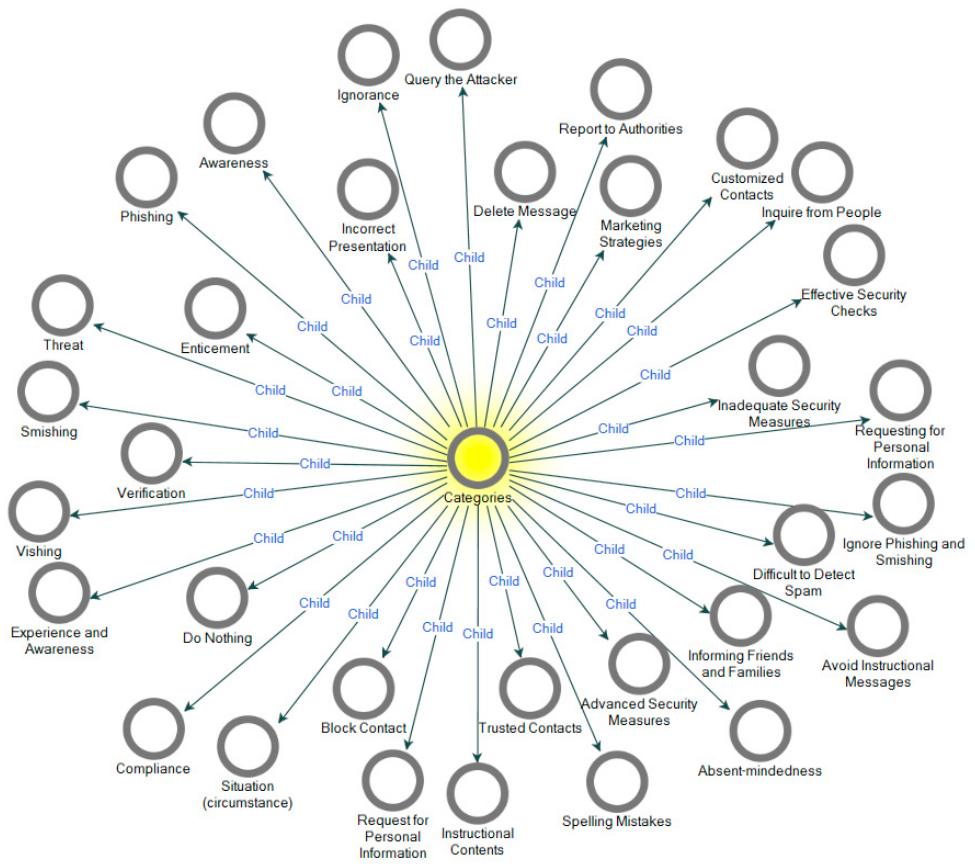
Figure 2. Abstracted 33 categories (free nodes) during open coding.